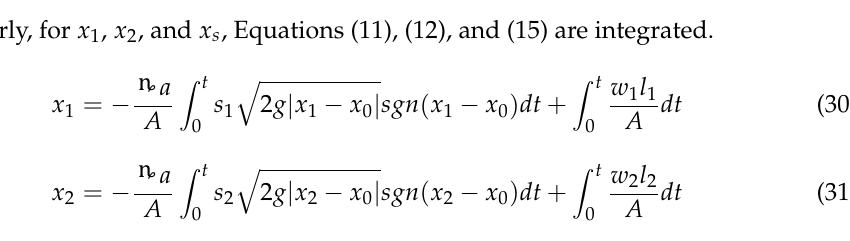
Figure 1. Three-pond hydraulic